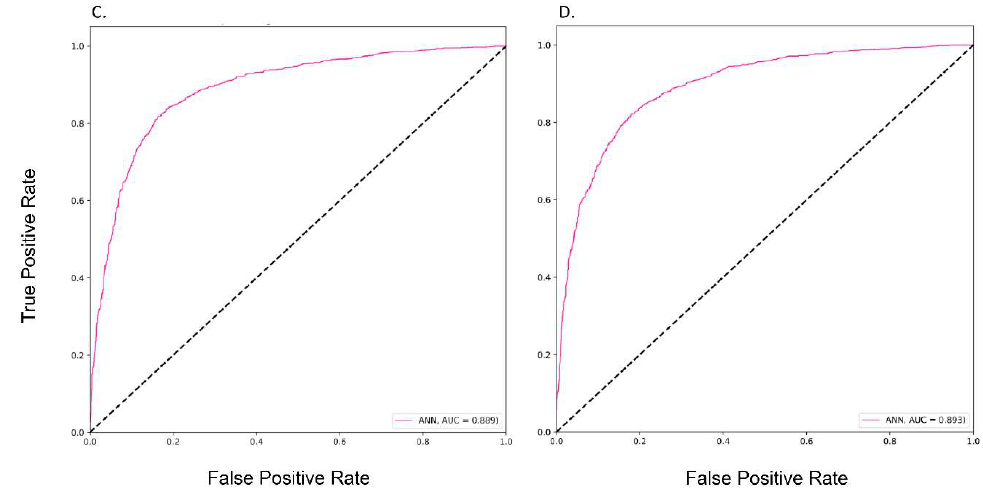
Figure 2. The Performance of the ANN Prediction Models in the Testing dataset by different Modes.